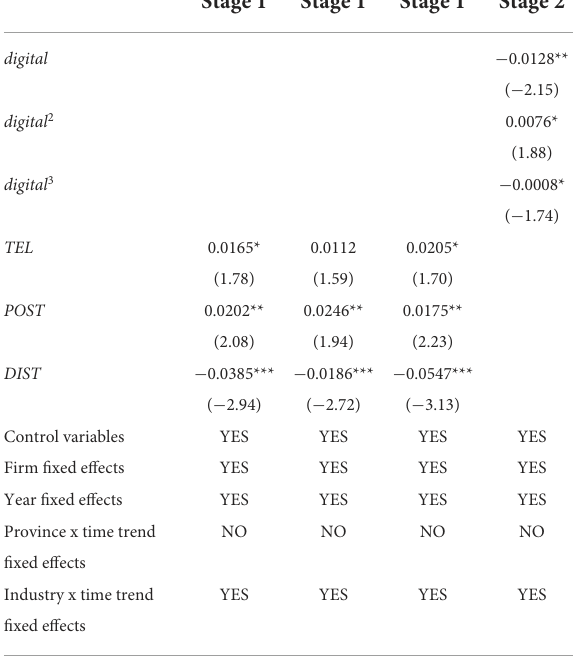
TABLE 3 Results of the endogeneity analysis.